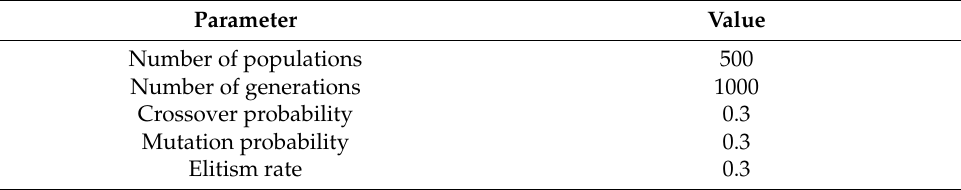
Figure 4. The structure of the chromosome. Table 1. Set parameters for the genetic